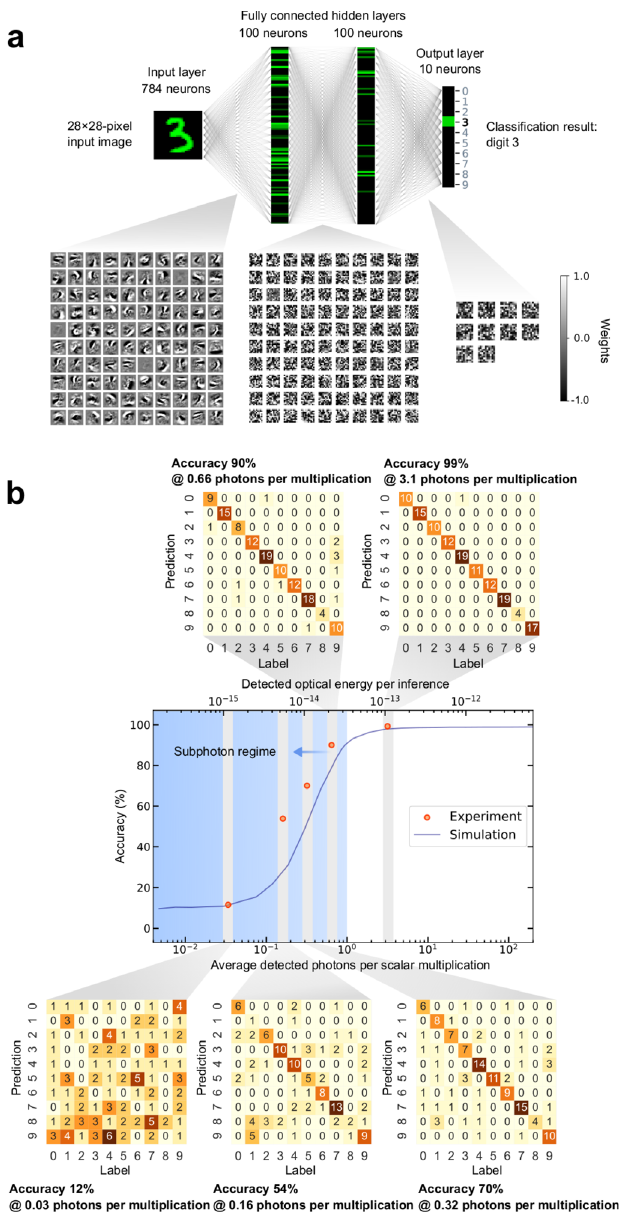
Fig. 3 MNIST handwritten-digit classi fi cation was demonstrated with an optical neural network using less than one detected photon per scalar multiplication. a Illustration of the 4-layer neural network for handwritten- digit classi fi cation that we implemented as an ONN. Top panel: the neural network is composed of a sequence of fully connected layers represented as either a block (input image) or vertical bar (hidden and output layers) comprising green pixels, the brightness of which is proportional to the activation of each neuron. The weights of the connections between neurons for all four layers are visualized; the pixel values in each square array (bottom panel) indicate the weights from all the neurons in one layer to one of the neurons in the next layer. b Classi fi cation accuracy tested using the MNIST dataset as a function of optical energy consumption (middle panel), and confusion matrices of each corresponding experiment data point (top and bottom panels). The detected optical energy per inference is de fi ned as the total optical energy received by the photodetector during the execution of the three matrix-vector multiplications comprising a single forward pass through the entire neural network. The shaded area in the plot indicates the regime where less than 1 detected photon was used for each scalar multiplication. Each shaded vertical bar in the plot directs to the confusion matrix corresponding to each experimental